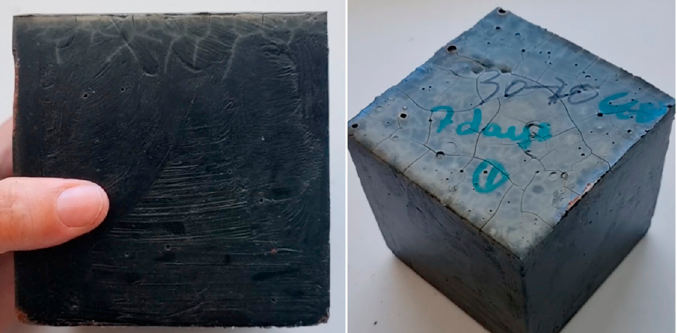
Figure 3. Preliminary study 30% DM ‐ 70% GGBS, 50 × 50 × 50 mm 3 Cubic Specimen Images.